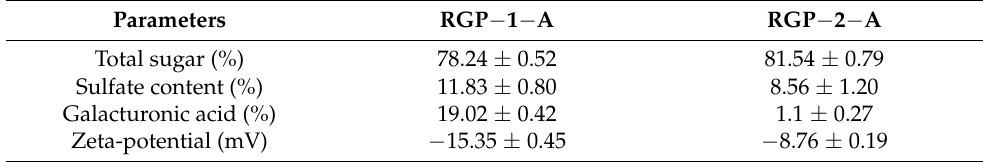
Table 3. Properties of different